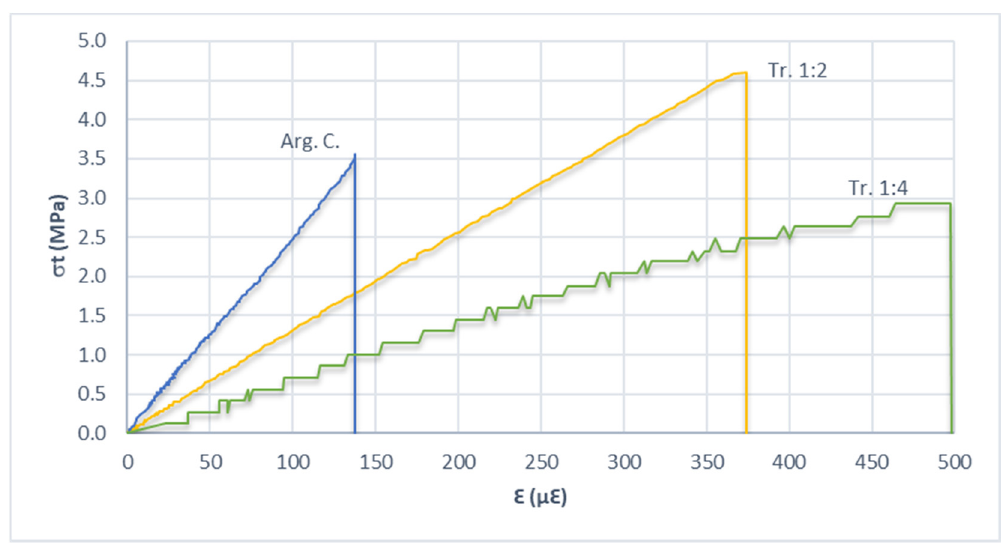
Figure 5. Stress–strain diagrams for tensile bending tests.